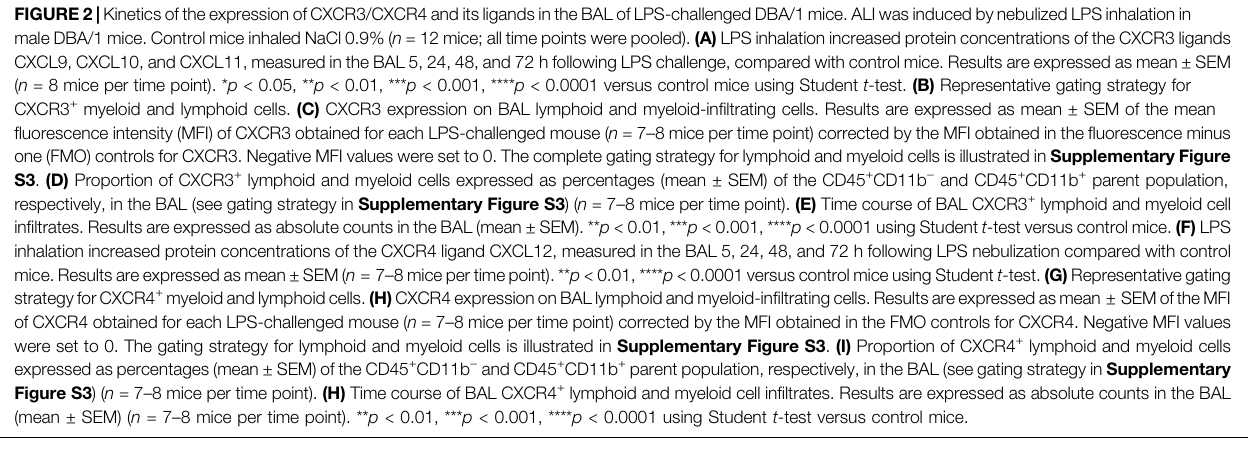
(Penh) AUC versus vehicle-treated mice challenged with NaCl ( Figure 5A ). A single oral administration of ACT-1004-1239 (100 mg/kg, p.o.), given 1-h prior to LPS challenge, signi fi cantly reduced the LPS-induced elevated Penh AUC, reaching values from control mice at the end of the evaluation period ( Figure 5A ),